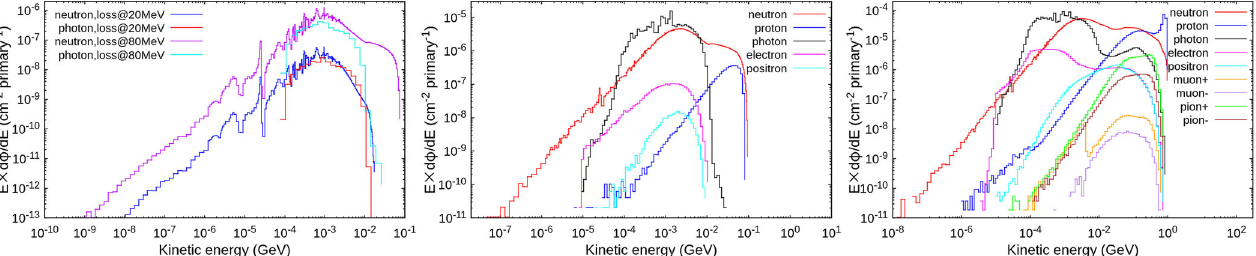
FIG. 6. Secondary particle fluence spectra outside of the DTL tank for beam loss at the energy of 20 and 80 MeV (left) and spectra outside of the RCS beam pipe at the energy of 100 MeV (middle) and 1.0 GeV